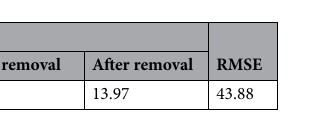
Table 1. Evaluation of denoising of single-frequency